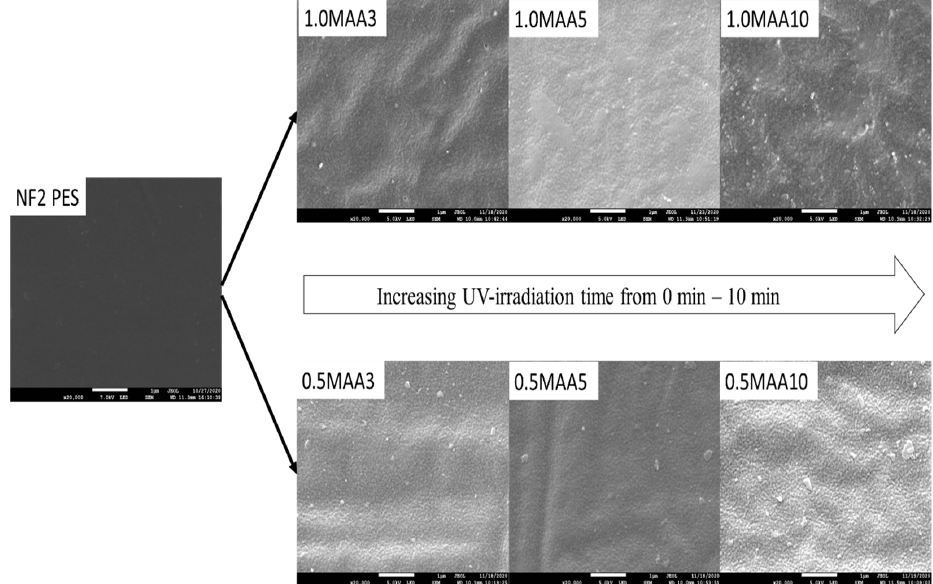
Membranes 2023 , 13 , x FOR PEER REVIEW 16 of 21 Figure 11. FESEM images (20,000× magnification) of the top membrane surface showing the effect Figure 11. FESEM images (20,000 × magnification) of the top membrane surface showing the effect of of UV irradiation time. UV irradiation time.